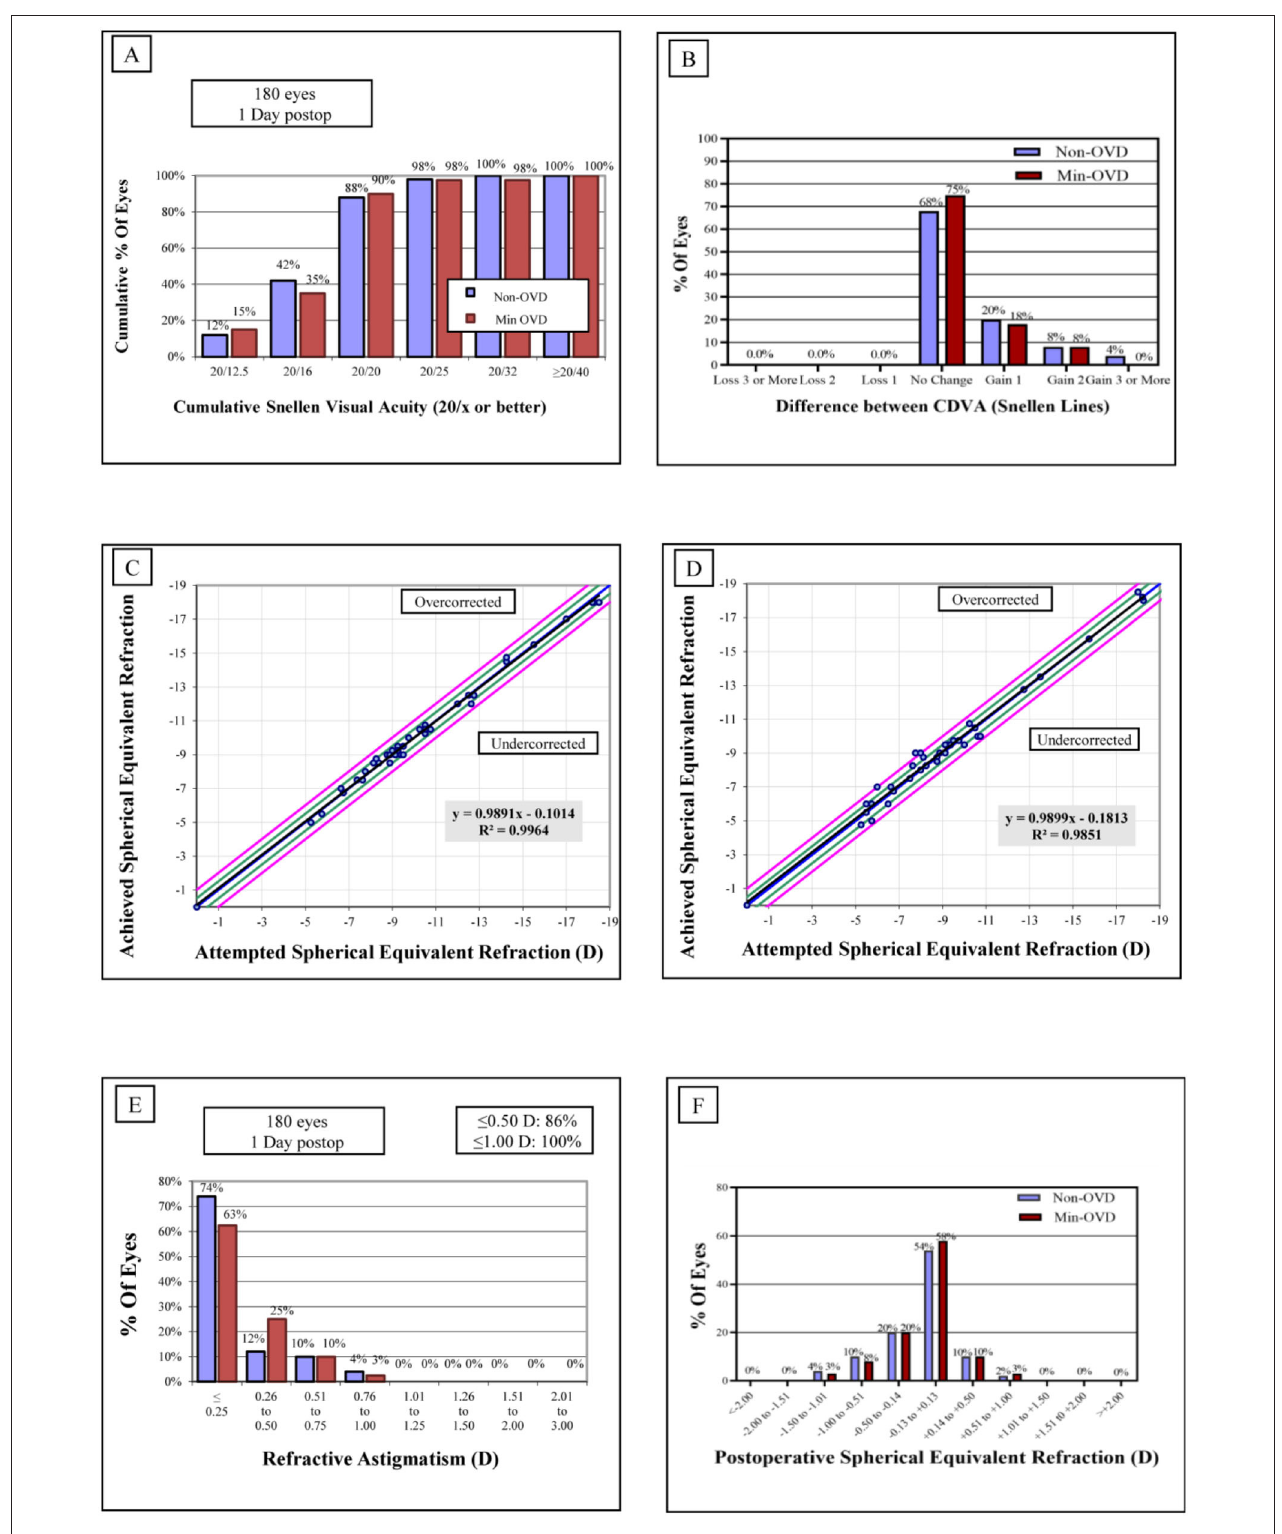
FIGURE 1 | Refractive outcomes 1 day after implantable collamer lens (ICL). (A) Cumulative uncorrected distance visual acuity (UDVA). (B) Changes of corrected distance visual acuity (CDVA). (C,D) Attempted vs. achieved SE refraction after ICL in the non-OVD group (C) and min-OVD group (D) . (E) Refractive astigmatism. (F) Spherical equivalent (SE)